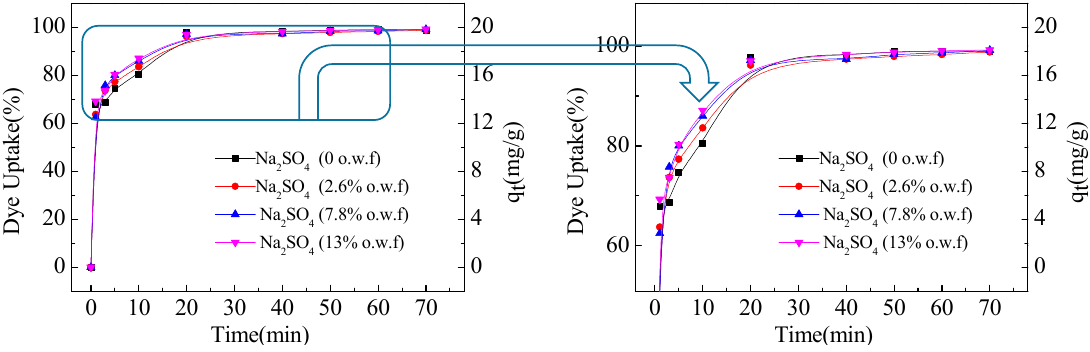
0 Figure 2. Uptake of dye of C.I. Reactive Red 120 with di ff erent sodium sulfate concentrations. Figure 2. Uptake of dye of C.I. Reactive Red 120 with different sodium sulfate